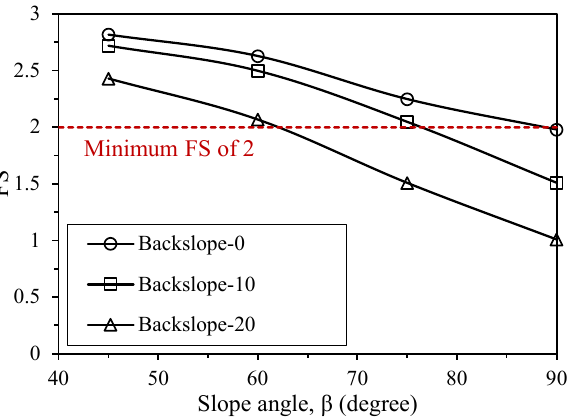
Figure 15. Effect of optimum nail layout for enhancing FS with slope angle.